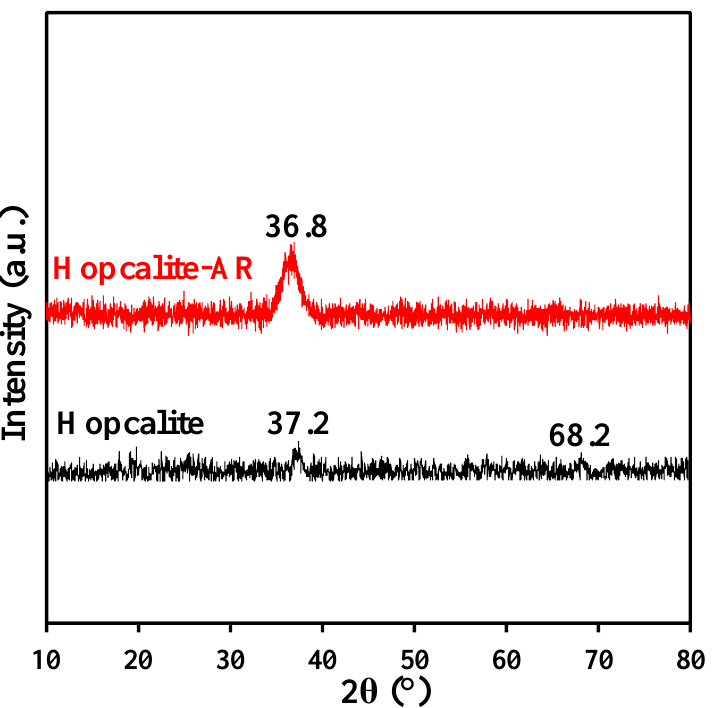
Figure 5. The XRD patterns of Hopcalite before and after reaction (AR, meaning after 15 NTP exposures).